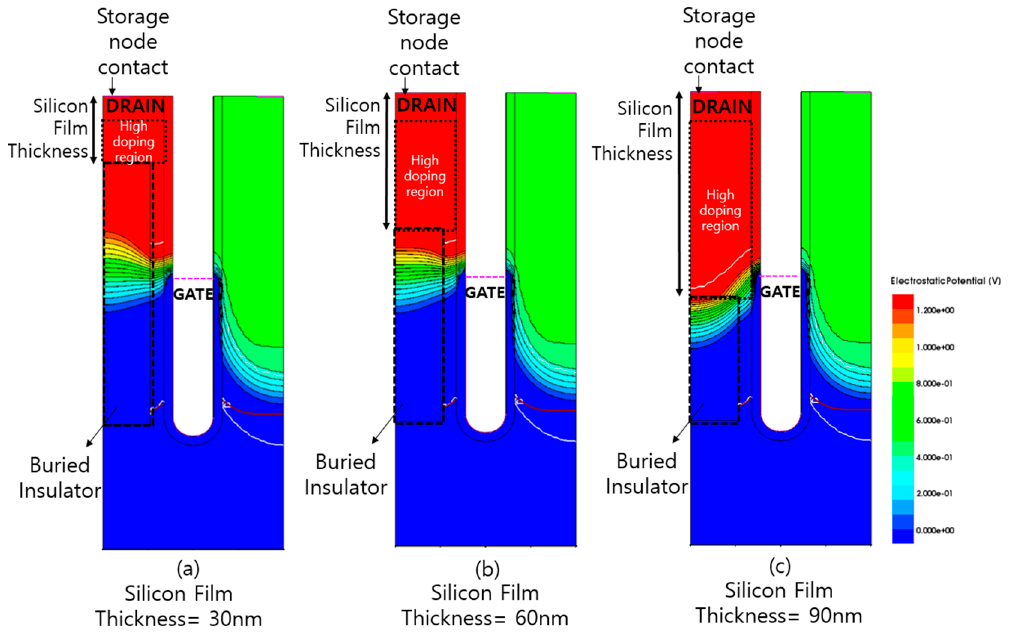
Figure 11. Electrostatic potential distribution according to the silicon film thickness of Pi-BCAT.